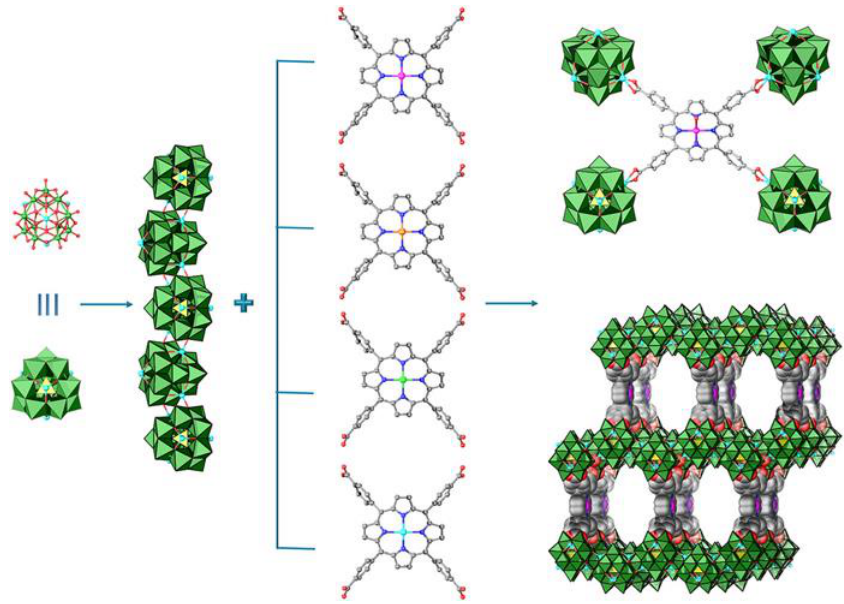
Figure 4. Schematic illustration of the structures of M-PMOFs (M = Co, Fe, Ni, Zn). M-TCPP: tetrakis [4-carboxyphenyl]-porphyrin-M (M-TCPP) linkers [76].